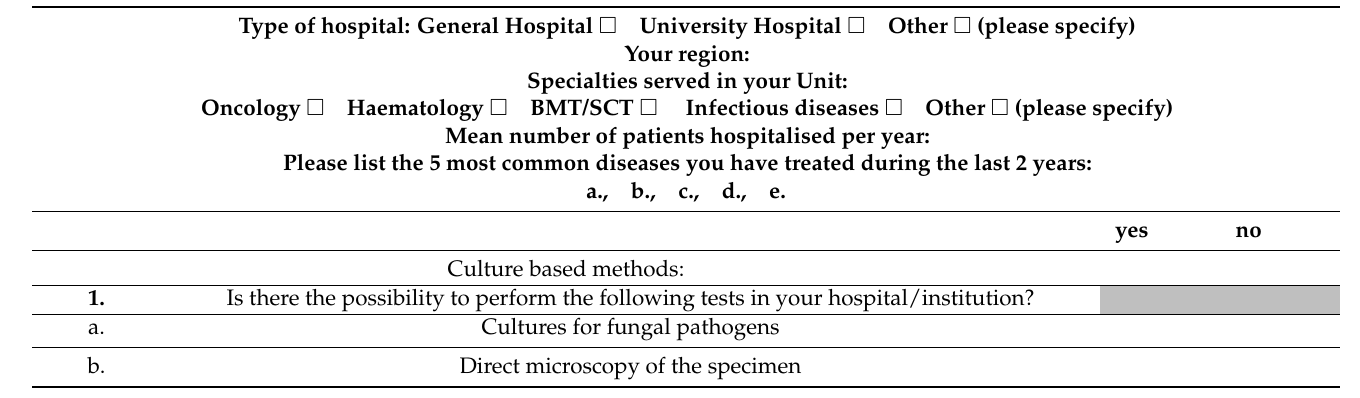
Table 1. Questionnaire on the diagnostic capacity for invasive fungal infections in the Greek paediatric haematology- oncology